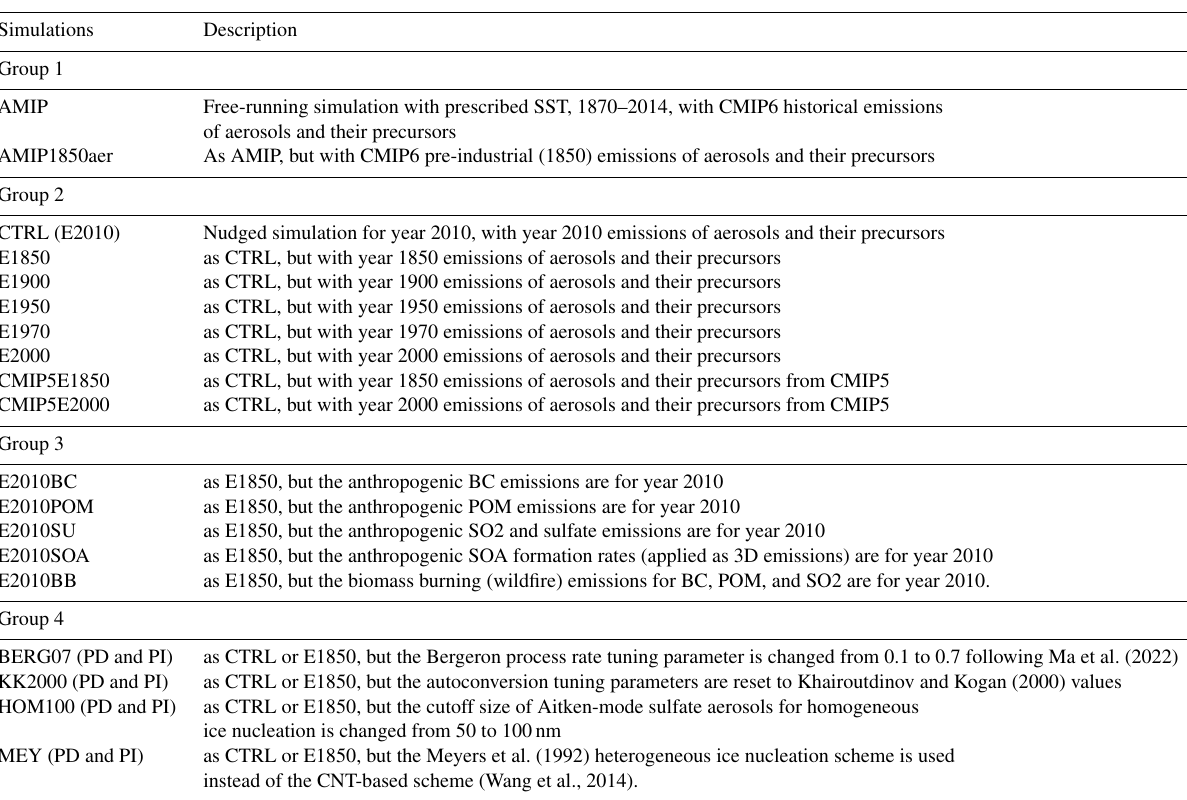
Table 1. List of simulation configurations. Note that for SOA, the 3D formation rates calculated based on Shrivastava et al. (2015) are applied as emissions in